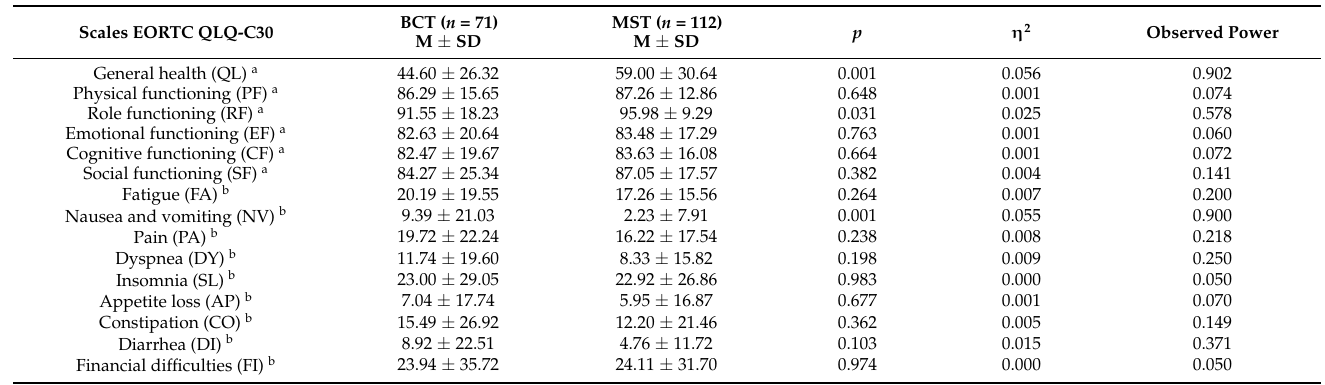
Table 4. Mean score of all items in EORTC QLQ-C30 of the study group (BCT vs. MST).